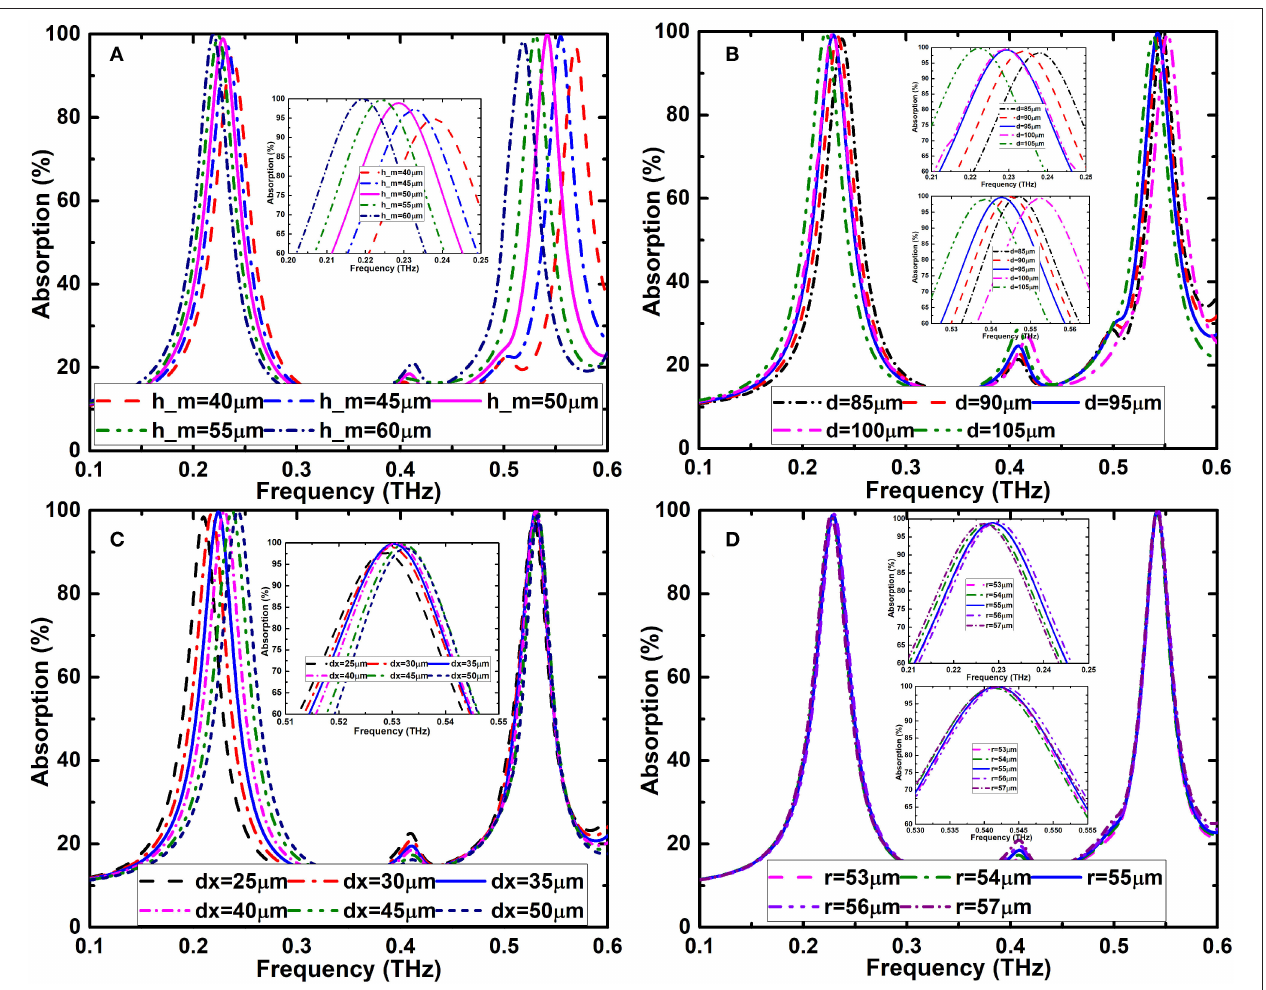
FIGURE 5 | Absorption spectra under (A) different dielectric layer thickness h_m when d = 95 µ m, dx = 35 µ m, r = 55 µ m; (B) different distance d when h_m = 50 µ m, dx = 35 µ m, r = 55 µ m; (C) different width dx when h_m = 50 µ m, d = 95 µ m, r = 55 µ m; (D) different radius r when h_m = 50 µ m, d = 95 µ m, dx = 35 µ